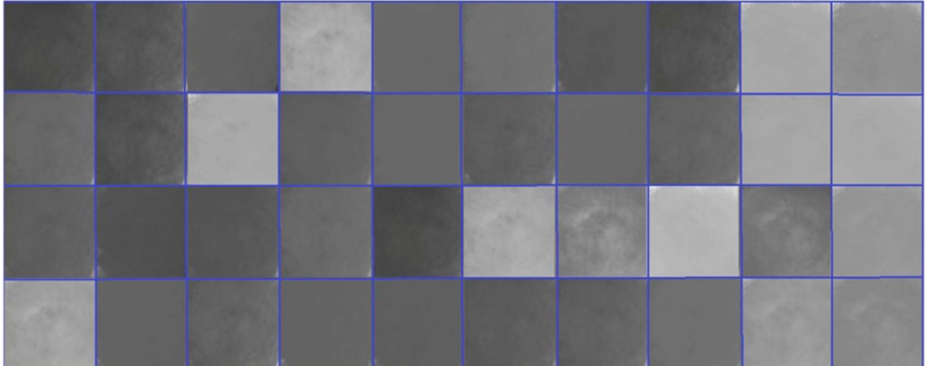
Figure 10. The learned filter of the normal